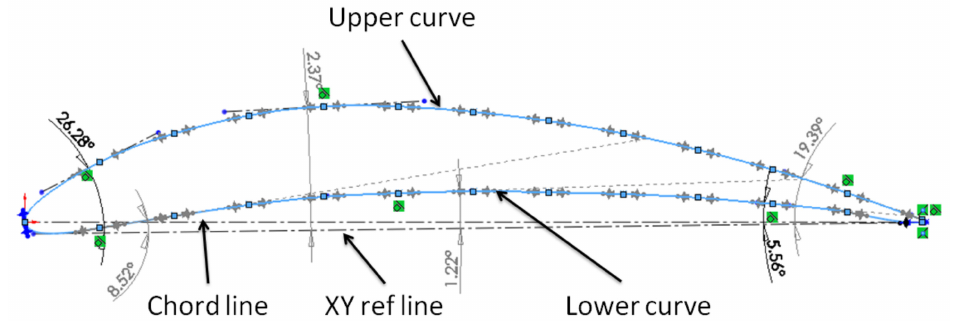
Figure 2. Terminology of asymmetrical airfoil curve—NACA 8410.